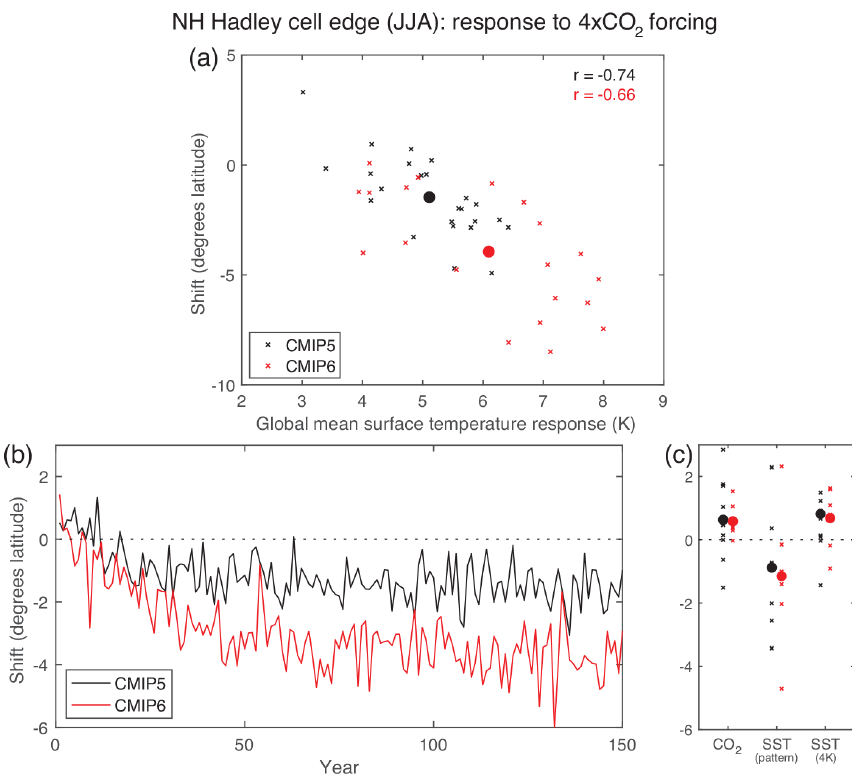
Figure 2. (a) Scatterplot of NH JJA Hadley cell edge response to 4 × CO 2 forcing (as measured by PSI500 metric) versus annual-mean global- mean surface temperature response for (black) CMIP5 and (red) CMIP6 models. (b) Time series of NH JJA Hadley cell edge response to abrupt 4 × CO 2 forcing for (black) CMIP5 and (red) CMIP6 multi-model mean. (c) Response of NH JJA Hadley cell edge to (first column) quadrupled atmospheric CO 2 concentrations with fixed sea surface temperatures (amip4 × CO 2 – AMIP), (second column) patterned sea surface temperature increase with fixed atmospheric CO 2 concentrations (amipFuture – AMIP), and (third column) uniform 4K sea surface temperature increase with fixed atmospheric CO 2 concentrations (amip4K –